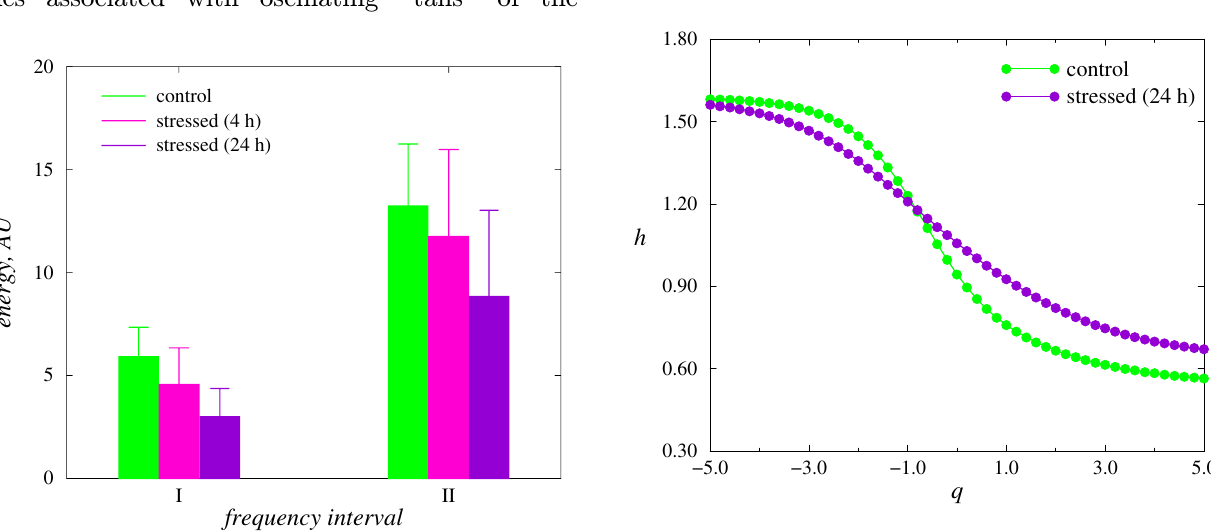
Fig. 4. Spectral energy estimated in two frequency intervals (mean (cid:1) SE).